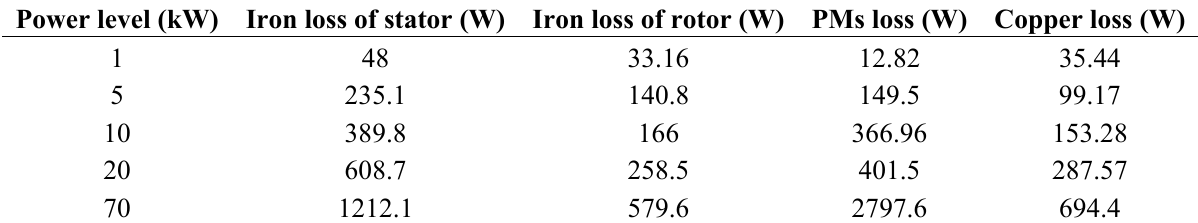
Table 4. Losses of different parts under rated load condition.